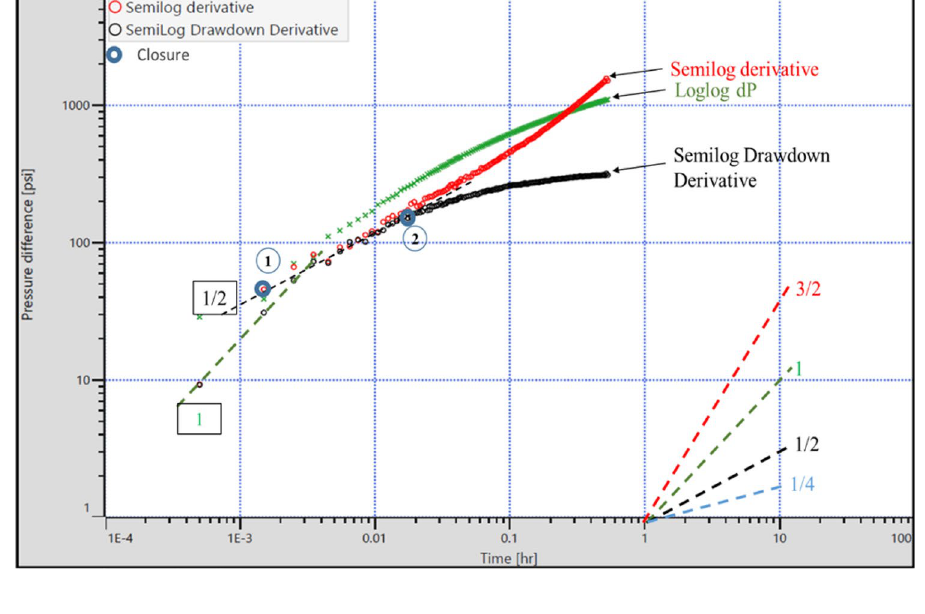
Fig. 8 A G-function plot for injection Cycle #3. Two pos- sible closure points: point 1 (shut-in = closure) and point